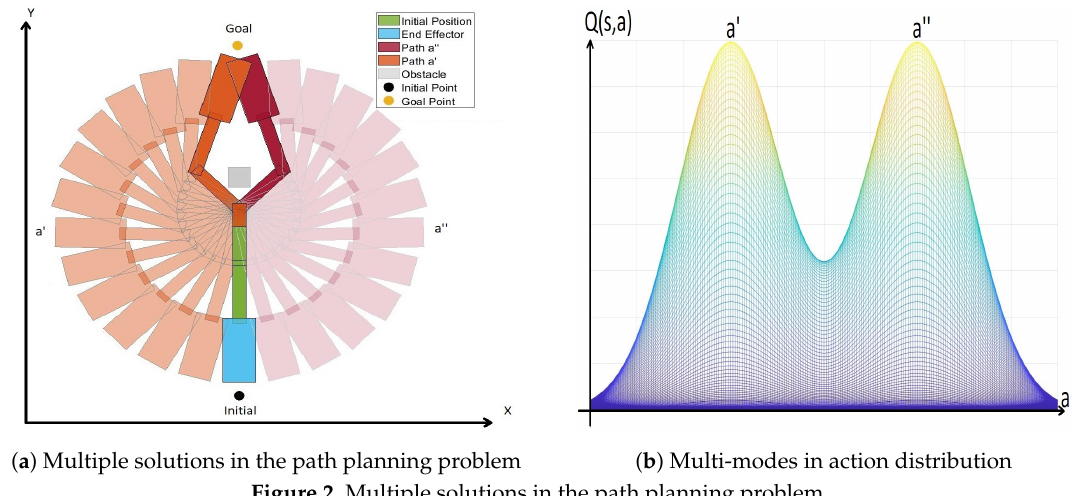
Figure 2. Multiple solutions in the path planning